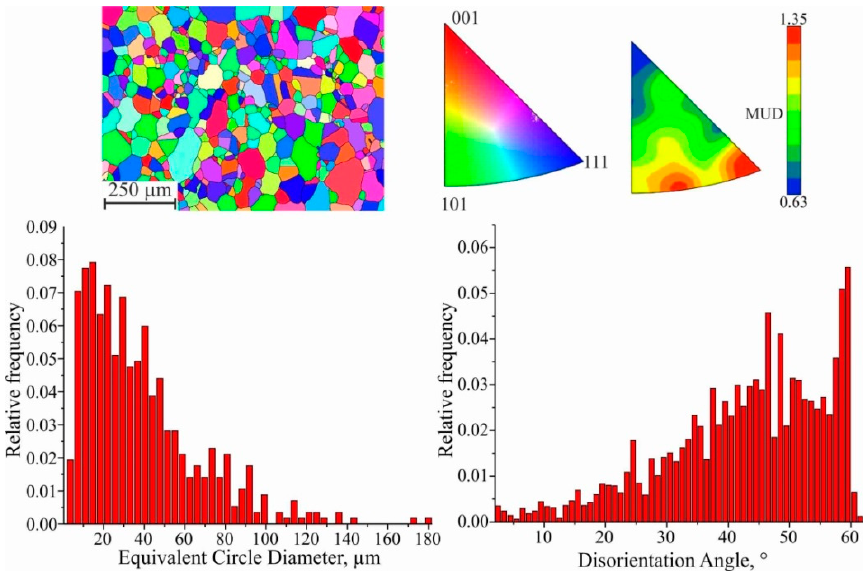
Figure 13. EBSD map fragment; grain size; disorientation; scattered and contoured IPFs for I area.